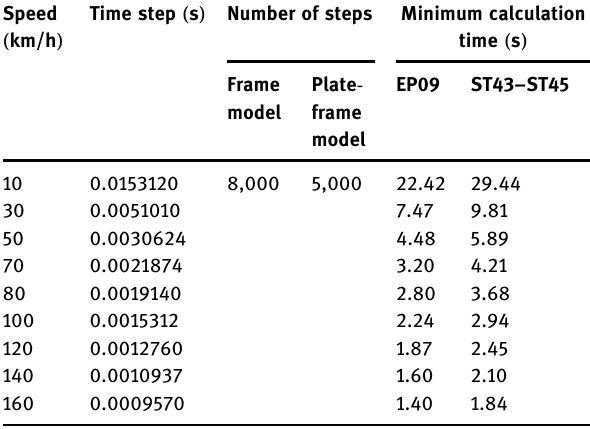
Table 5: The number of values of time steps for speci fi c speed values in the dynamic analysis Speed Time step ( s ) Number of steps ( km/h )